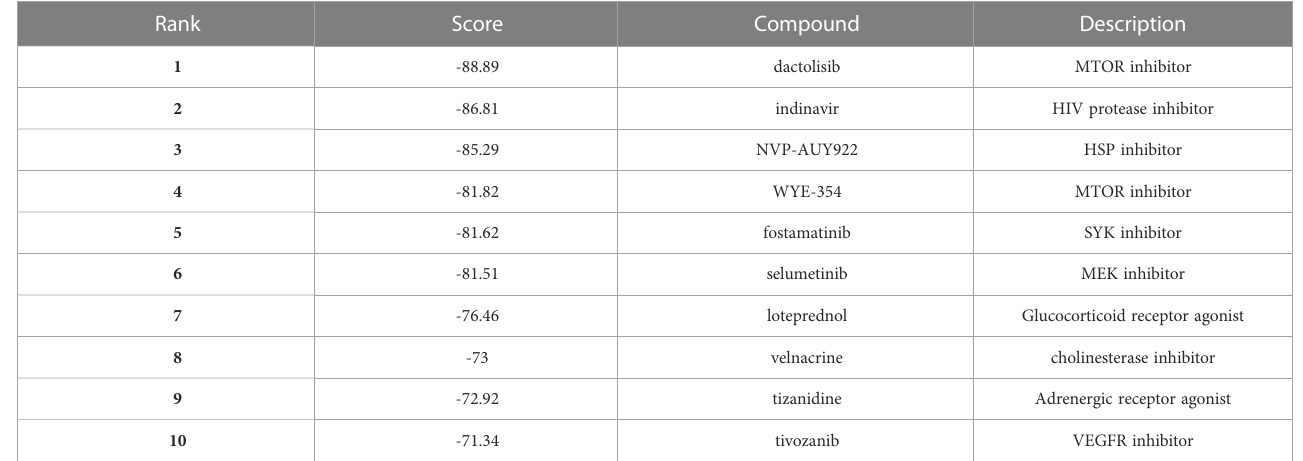
TABLE 1 10 compounds with the highest negative enrichment score from Cmap database. Rank Score Compound